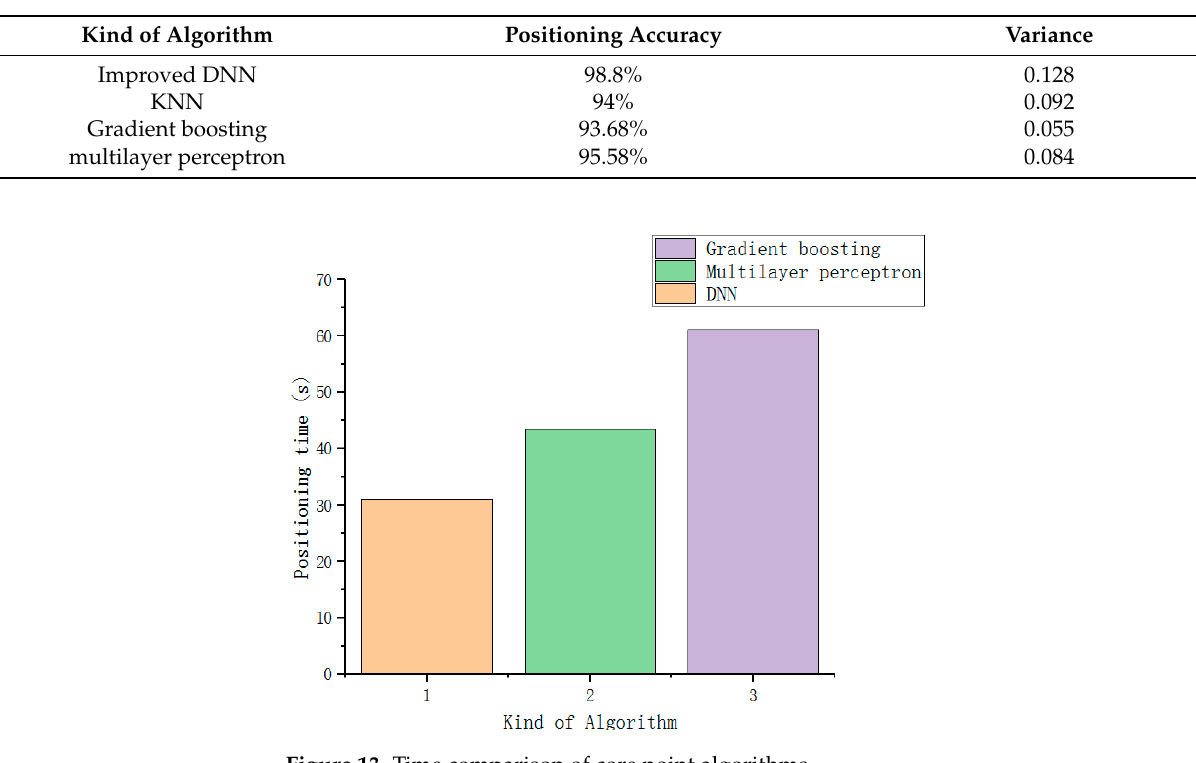
Figure 13. Time comparison of core point algorithms.